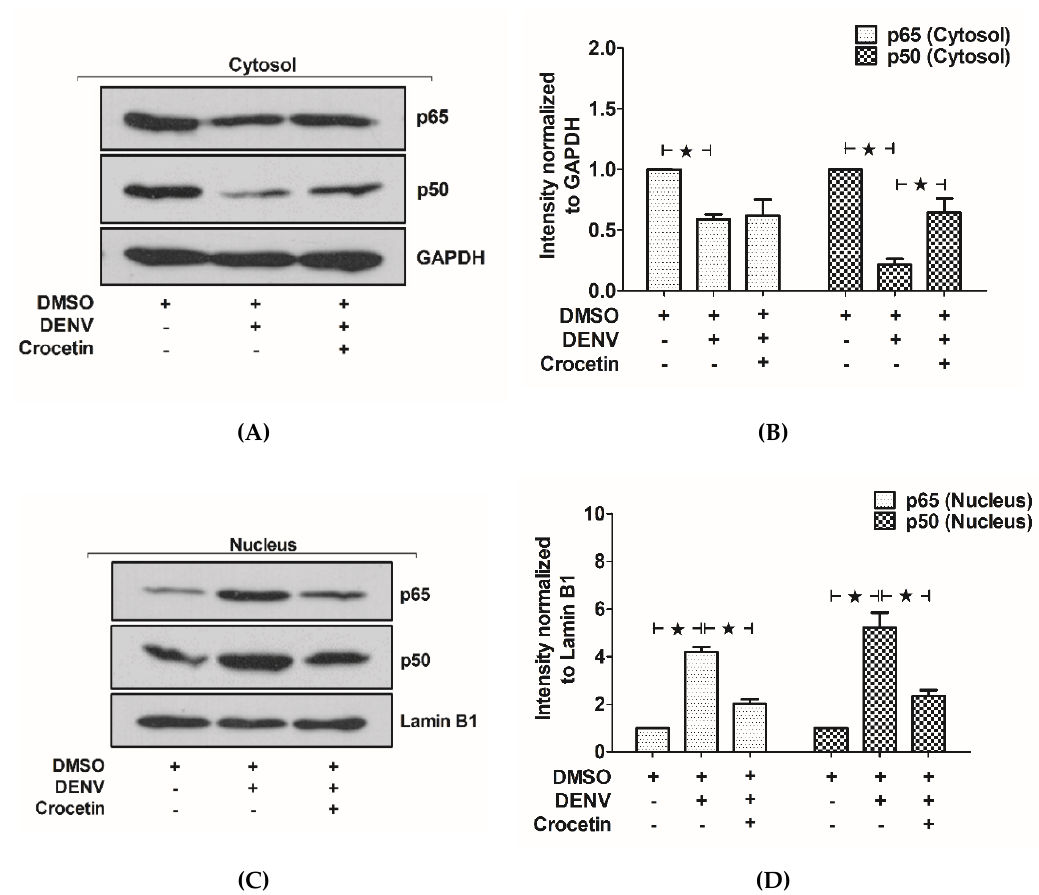
Figure 8. Crocetin reduced the nuclear translocation of NF-kB in the livers of DENV-infected mice. BALB/c mice were infected with DENV-2 (4 × 10 5 FFU/mL) and then treated with crocetin (50 mg/kg) dissolved in 2% DMSO. DENV-infected 2% DMSO-treated and mock-infected 2% DMSO-treated groups of mice were used as positive and negative controls, respectively. Protein samples were prepared from liver tissues, and cellular fractionation was conducted. The cytosolic and nuclear fractions of the proteins were subjected to Western blot analysis, and the results were normalized to that of GAPDH (cytosolic housekeeping gene) and Lamin B1 (nuclear housekeeping gene). Densitometry analysis of blots was conducted using ImageJ software normalized to the individual housekeeping genes. ( A ) Western blot analysis of NF-kB p65 and p50 from the cytosolic fraction. ( B ) Densitometry analysis of NF-kB p65 and p50 from the cytosolic fraction. ( C ) Western blot analysis of NF-kB p65 and p50 from the nuclear fractions. ( D ) Densitometry analysis of NF-kB p65 and p50 from the nuclear fractions. The black star represents, those groups were compared and found to be significant. A graphical representation of the proposed e ffi cacy of crocetin treatment in DENV-infected mice is shown in Figure